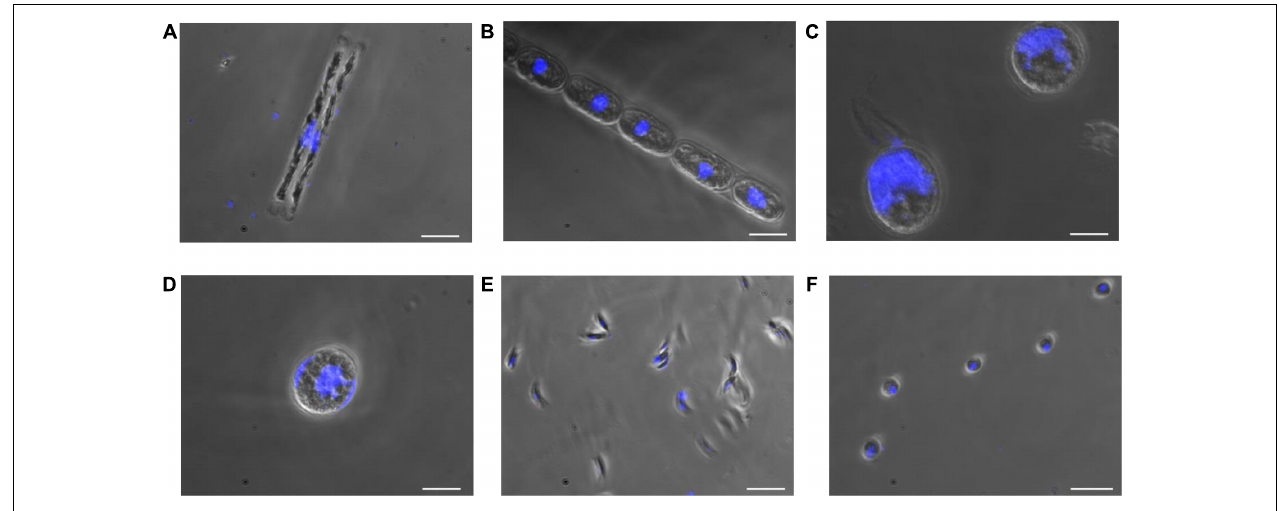
FIGURE 2 | Nucleus and cell sizes of phytoplankton cells (A) D. tenuis, (B) M. arctica, (C) A. malmogiense, (D) K. foliaceum, (E) Monoraphidium sp., and (F) C. pyrenoidosa were compared using microscope for visualization. DNA of the cells was stained with DAPI. Scale bars, 20 µ